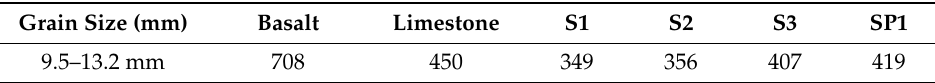
Table 11. Texture of investigated coarse aggregate.